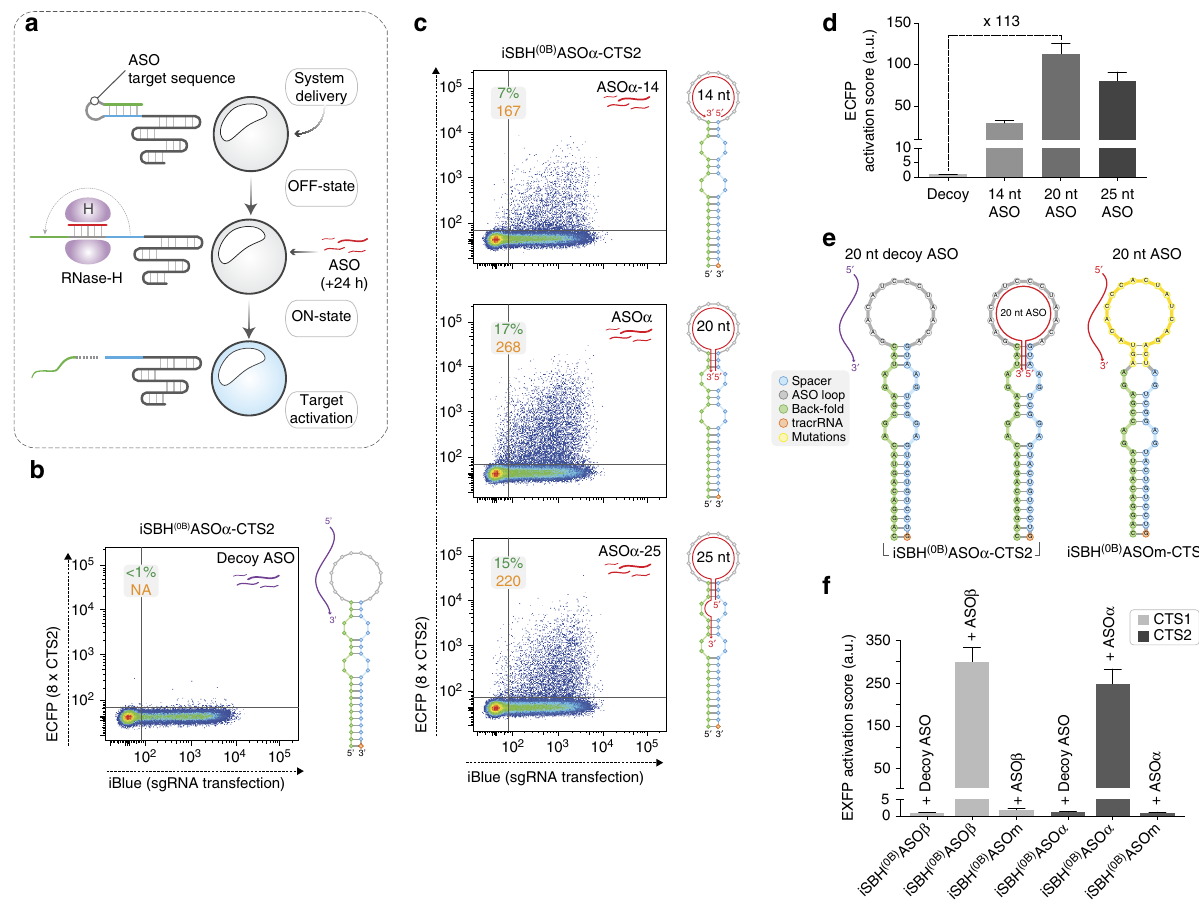
Figure 3 | Design and optimization of ASO-responsive iSBH-sgRNAs. ( a ) Implementation of ASO-responsive iSBH designs for temporal control of CRISPR-TR activity. This platform enables delayed sgRNA activation by means of externally delivered cognate ASOs. ( b ) CRISPR-TR assay (ECFP reporter expression flow cytometry) in the presence of iSBH (0B) ASO a -CTS2 and a decoy ASO with scrambled sequence (purple, incompatible base pairing with the sensing loop). ( c , d ) Impact of ASO length on the activation of iSBH (0B) ASO a -CTS2 sgRNA (ON-state). Representative flow cytometry scatter plots and corresponding ASO/iSBH pairing diagrams using 14-, 20- and 25-nucleotide (nt) long ASO inducers (red) ( c ). Quantification of ON-state reporter activation score for the conditions shown in b , c ( n ¼ 3, mean ± s.d.; a.u., arbitrary units) ( d ). ( e , f ) Analysis of ON-state activation and OFF-state inhibition using the optimal 20nt ASO inducer design on two target genes (CTS1-EYFP and CTS2-ECFP). For each CTS three experimental conditions were compared: decoy ASO and iSBH-sgRNA; matching ASO and iSBH-sgRNA; and matching ASO and iSBH-sgRNA (non-matching sensing loop) ( e ). Quantification of reporter activation scores from three biological replicates for each condition. No activation above background was detected in control conditions (decoy ASO or matching ASO þ iSBH(0B)ASO m -CTS), while robust CRISPR-TR-mediated reporter expression was elicited by the presence of active ASOs ( f ). Flow cytometry plot insets show % of activated cells (double iBlue þ ve and ECFP þ ve , green) and median reporter fluorescence intensity for this population